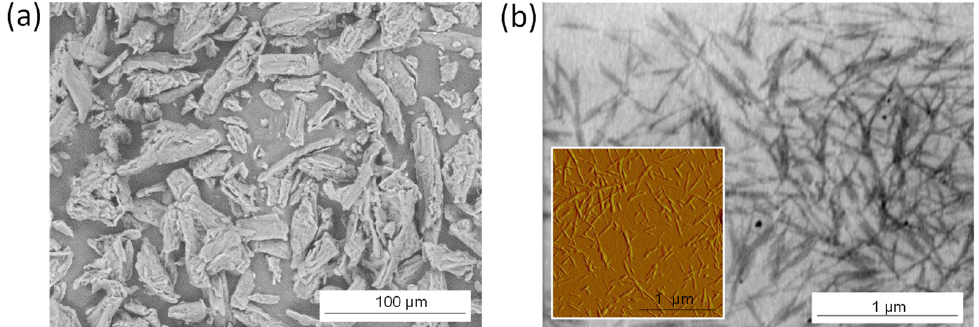
Figure 8. Morphology of cellulose materials used in this research: ( a ) microcrystalline cellulose (MCC) starting material; ( b ) cellulose nanocrystals (CNC) obtained after acid hydrolysis, according to SEM analysis (main pictures) and AFM (inset ( b )).